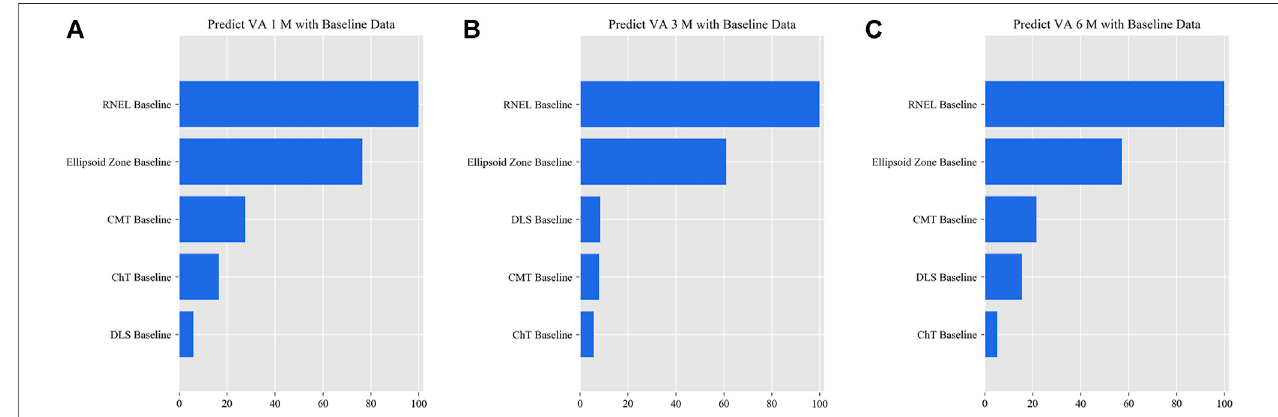
FIGURE7| Relativeimportanceofdifferentfeaturesforpredictionforsimpli fi edmodel Ⅲ .TheseplotsshowtheweightsofthedifferentfeaturesintheVAprediction task1,3,and6 months afterlasertreatmentformodel Ⅲ .Theresultswerestrati fi edaccordingtothefollow-upperiodandthepointsinputintothealgorithms;this fi gure shows only the relative importance of the baseline data. The red bar indicates the average importance of the feature in the blending algorithm. (A) Feature weights in the 1-month VA prediction. (B) Feature weights in the 3-month VA prediction. (C) Feature weights in the 6-month VA prediction.